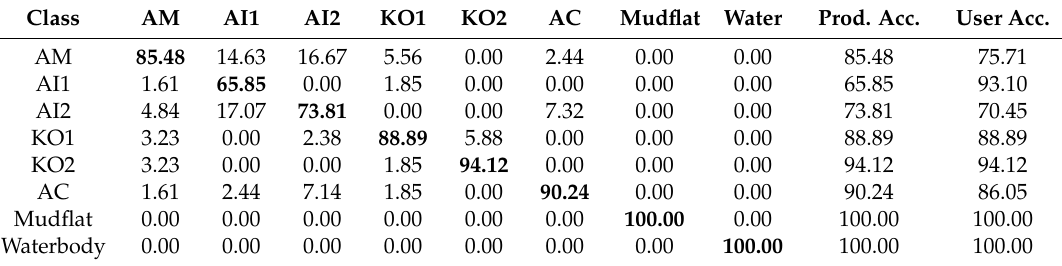
Table 5. Confusion matrix calculated from SVM + OST classification